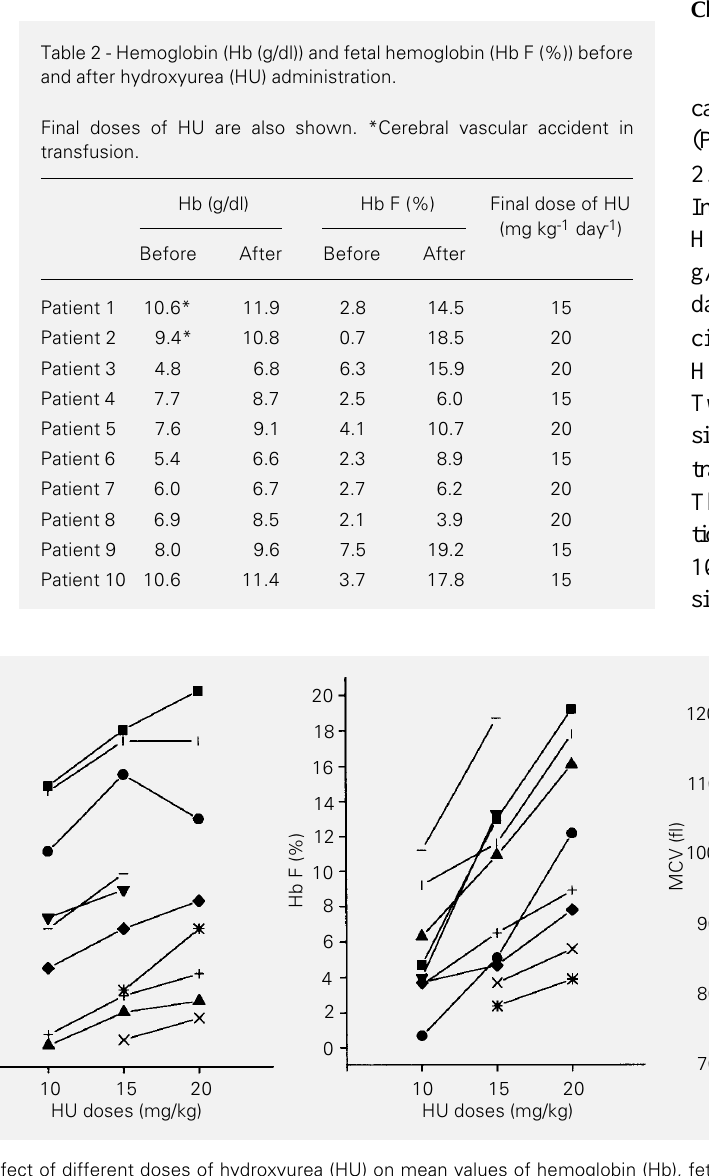
Figure 1 - Effect of different doses of hydroxyurea (HU) on mean values of hemoglobin (Hb), fetal hemoglobin (Hb F) and mean corpuscular volume (MCV) for 8 patients with sickle cell anemia (patients 1-8) and 2 patients with S(cid:223) thalassemia (patients 9 and